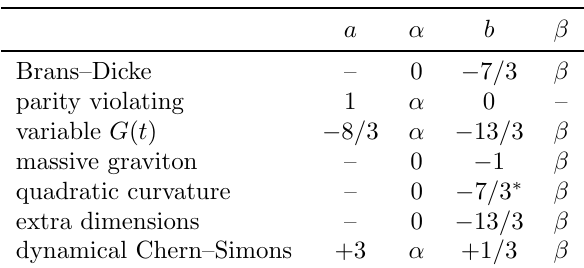
Table 2: Leading-order effects of alternative theories of gravity, as represented in the ppE framework [Eq. (52)]. For GR 𝛼 = 𝛽 = 0. This table is copied from [134], except for the two entries labeled with an asterisk. The quadratic curvature ppE exponent given in [134] was 𝑏 = − 1 / 3, coming from the conservative dynamics. However, it was shown in [483] that the dissipative correction is larger, giving the value 𝑏 = − 7 / 3 quoted above. The dynamical Chern–Simons ppE exponent given in [134] was 𝑏 = 4 / 3, which was derived using the slow-rotation metric accurate to linear order in the spin [496]. At quadratic order in the spin [488], the corrections to both conservative and dissipative dynamics occur at lower post-Newtonian order, giving 𝑏 = 1 / 3